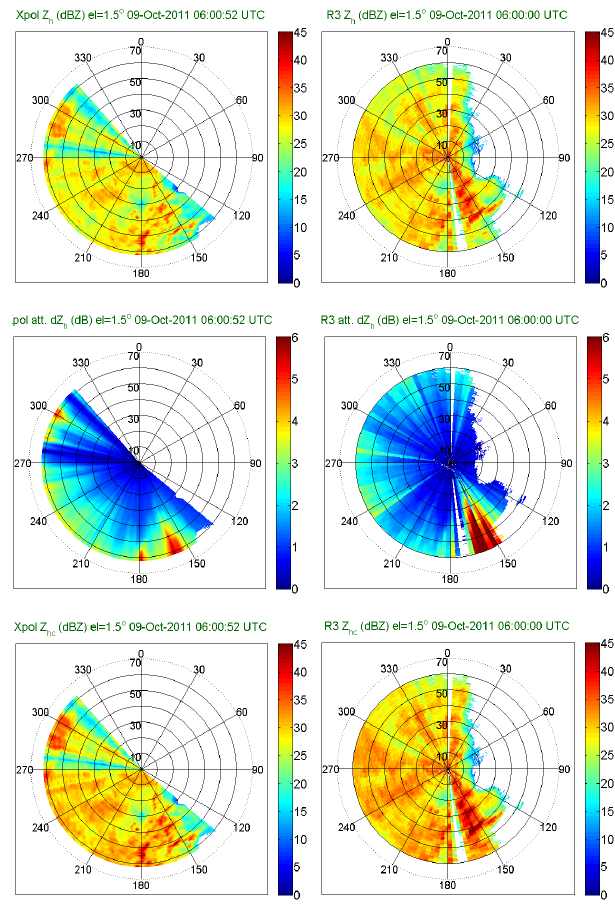
Figure 4. Sample PPI maps at 0.5° elevation angle of rain-path attenuation correction using Fig. 4. Sample PPI maps at 0.5 ◦ elevation angle of rain-path at- XPol (left column) and R3 mini-radar (right column) for the rain event on Oct. 9, 2011. PPIs tenuation correction using XPol (left column) and R3 mini-radar (right column) for the rain event on 9 October 2011. PPIs refer to refer to horizontally-polarized reflectivity Z hh , estimated specific attenuation dZ hh and horizontally-polarized reflectivity Z hh , estimated specific attenua- corrected reflectivity Z hc . tion dZ hh and corrected reflectivity Z hc